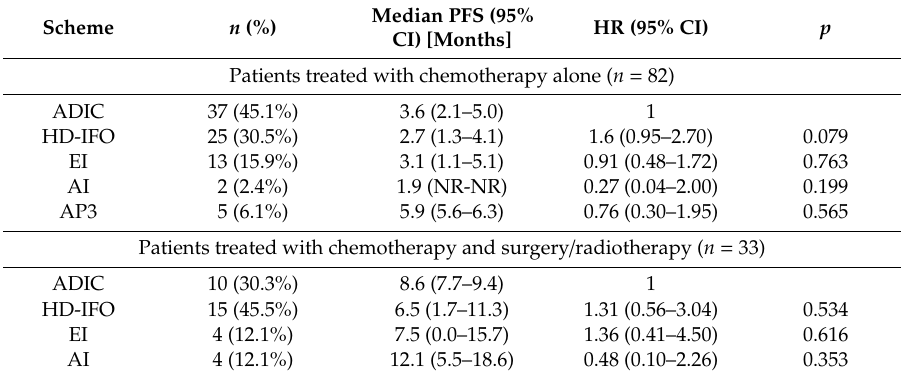
Table 3. Median progression-free survival (PFS) in the first line of treatment depending on the used chemotherapy regimen in patients who received chemotherapy alone or chemotherapy with surgery / radiotherapy.